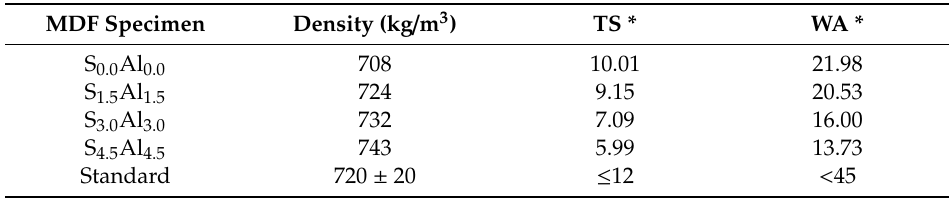
Table 10. The final physical properties of 16 mm MDF samples for di ff erent concentrations of alumina